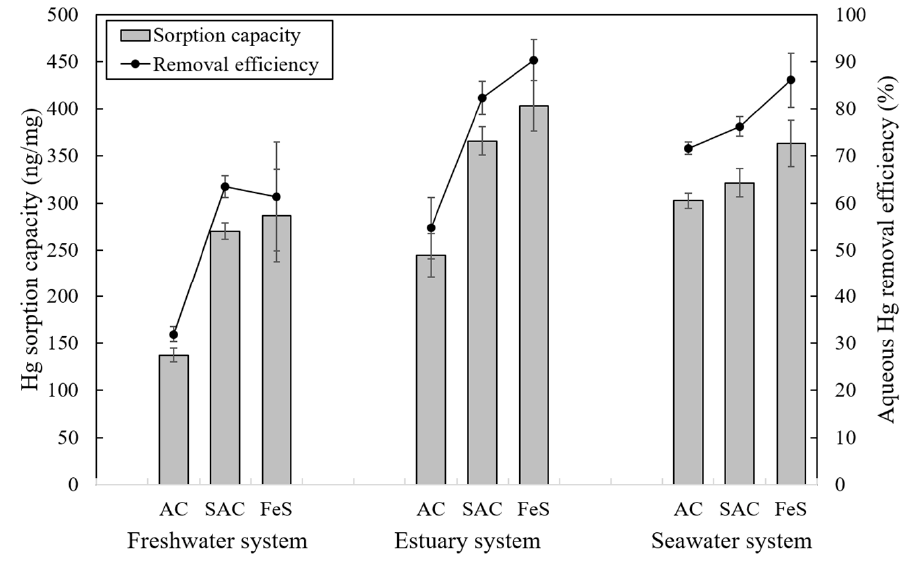
Figure 5. Comparison of the Hg sorption capacity at various salinity levels a ff ected by DOM.